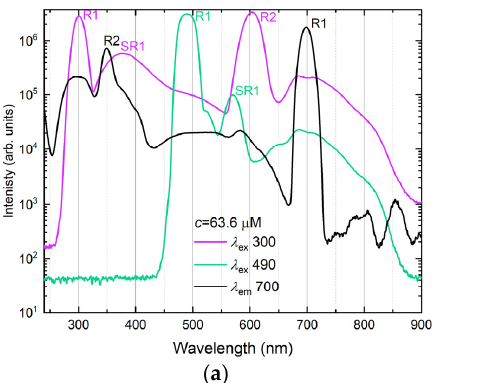
Table 1. Performance parameters of EEM fl uorescence quanti fi cation of fullerenes ( p = 0.95); exper-